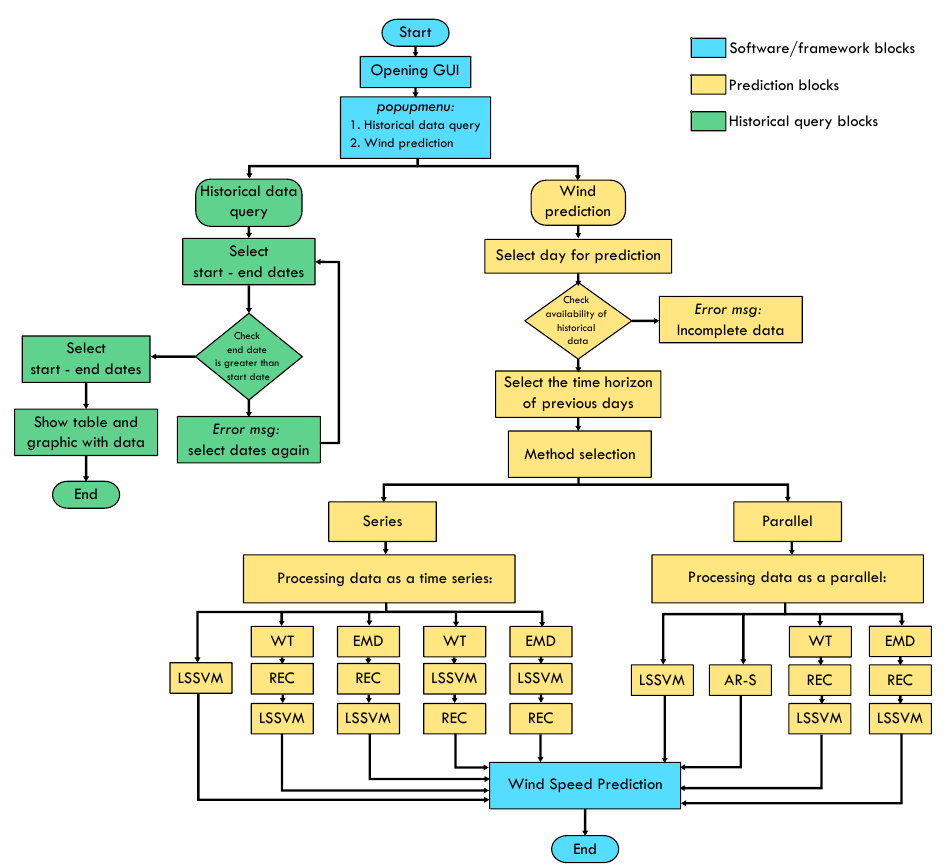
Figure 2. Flowchart for software tool